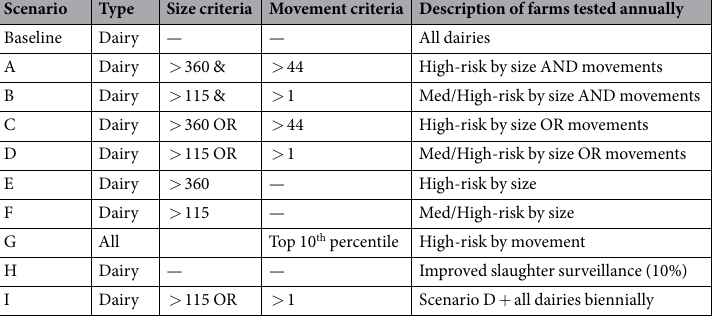
Table 2. Criteria for farms undergoing annual skin testing for 10 surveillance scenarios. Size criteria refers to the herd size of the farm in the current year. Movement criteria refers to the number of animals received in the previous three